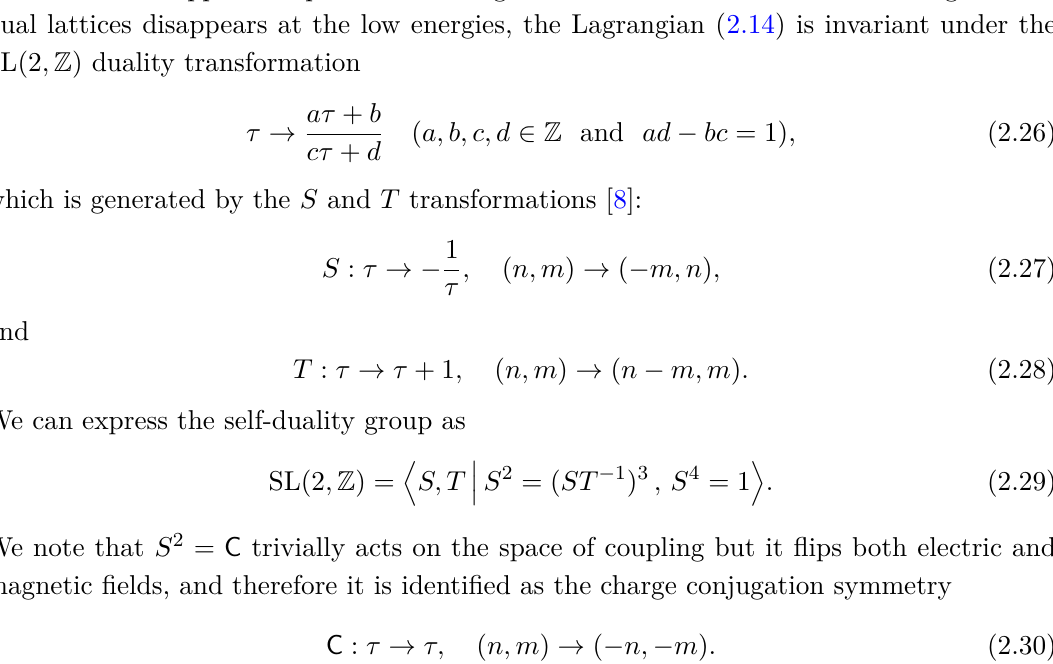
Figure 3 . The phase diagram of the model in the τ plane, with τ = θ case, where the system is gapped at any τ . The blue curves denote the phase transitions, and they are related by the self-dual transformations, SL(2 , Z )